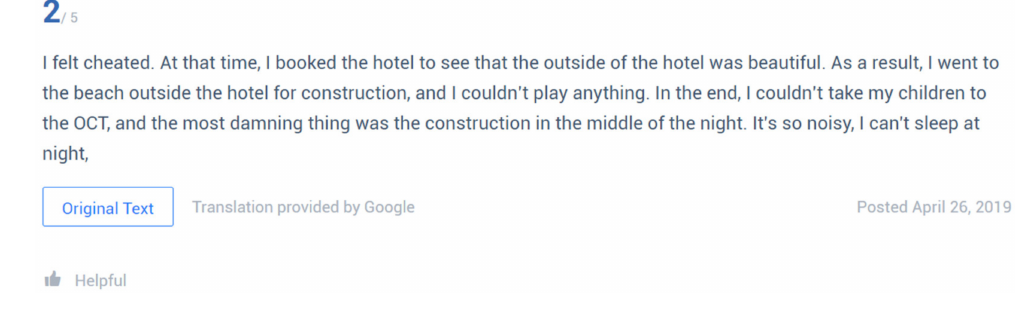
Figure 2. Screenshot of a text review.